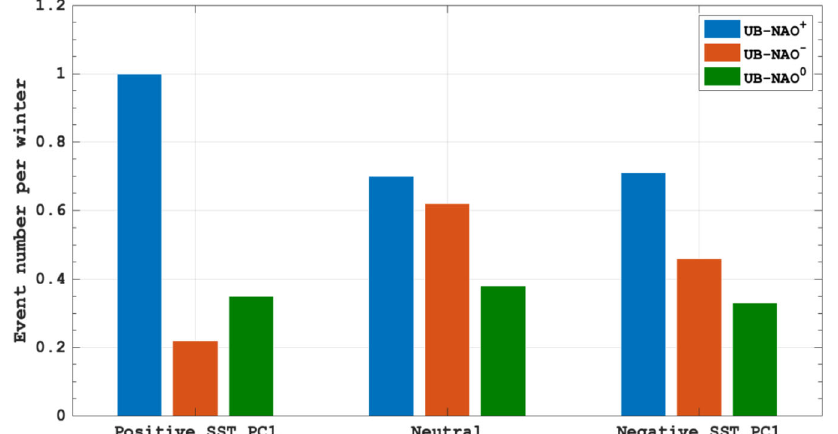
Fig. 5 | Variations of the event number of winter Ural blocking (UB) events concurrent with the different phases of North Atlantic Oscillation (NAO) with the phase of the Atlantic interannual variability. The percentage of UB events with three phases of NAO (UB-NAO + , UB-NAO - and UB-NAO°) with respect to total